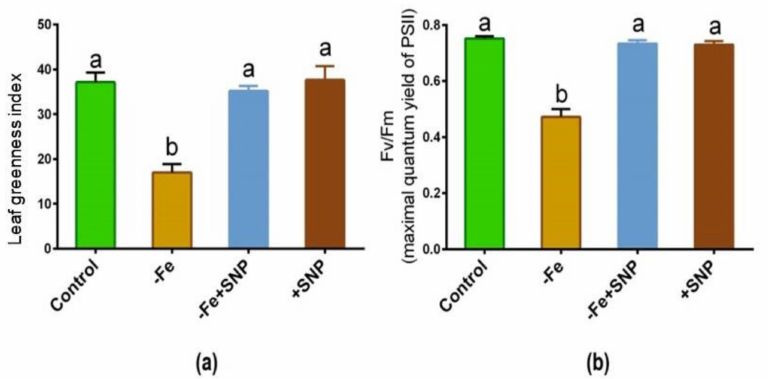
Figure 3. Leaf greenness ( a ) and maximum quantum yield of PSII ( b ) in alfalfa cultivated with different growth conditions: control (25 µ M FeNaEDTA); − Fe (0.1 µ M FeNaEDTA); − Fe (0.1 µ M FeNaEDTA) and sodium nitroprusside (SNP, 100 µ M) as nitric oxide (NO) donor; and SNP (100 µ M). Different letters above the error bar indicate significant differences ( p < 0.05) among means ± SD of treatments ( n = 3).